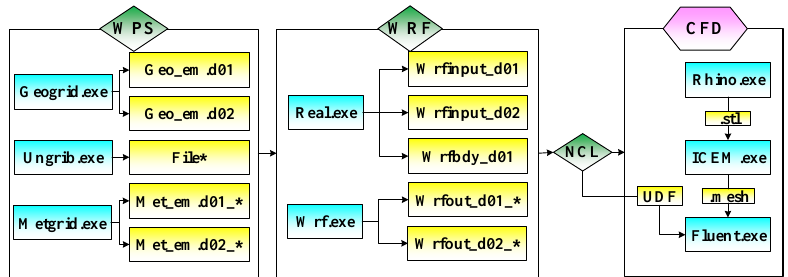
Figure 2. Flowchart of WRF-CFD wind field downscaling technology.